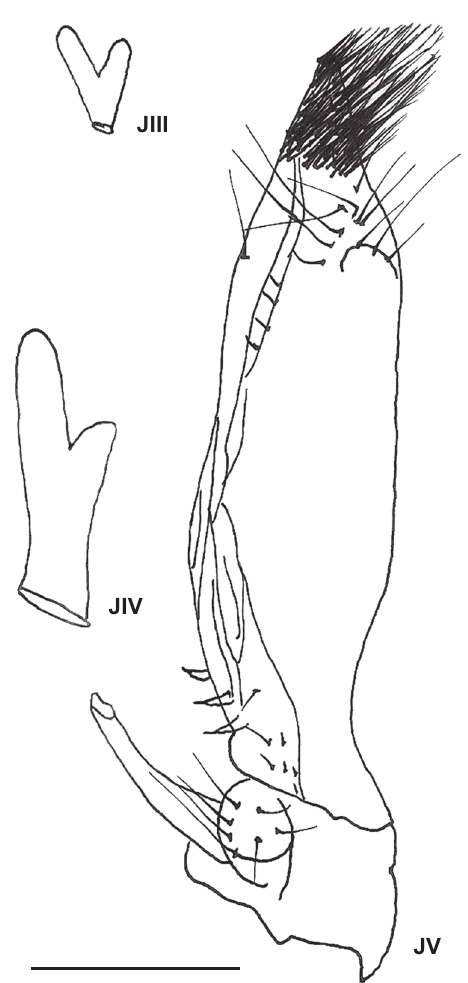
Figures 33. Pachygrapsus gracilis , juvenile instars. Male pleopod (Pl1) from juvenile III to V. Scale bar: JIII-JIV = 0.01 mm; JV = 0.02 mm.